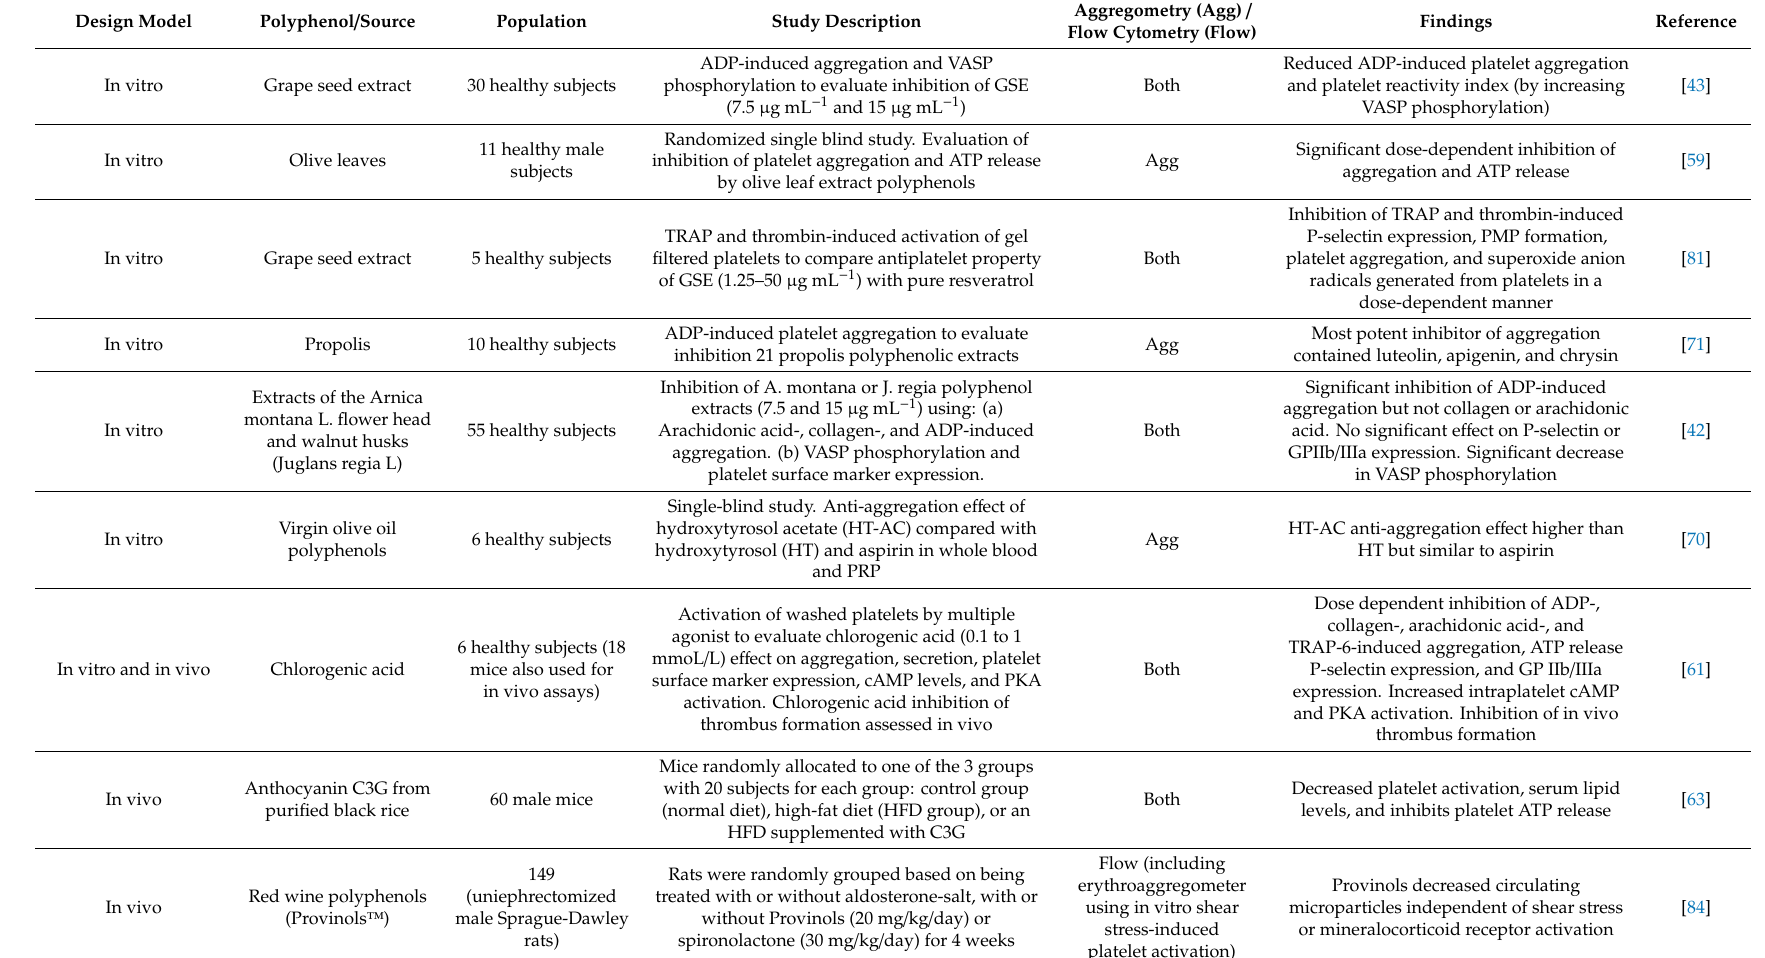
Table 1. E ff ect of polyphenols on platelet